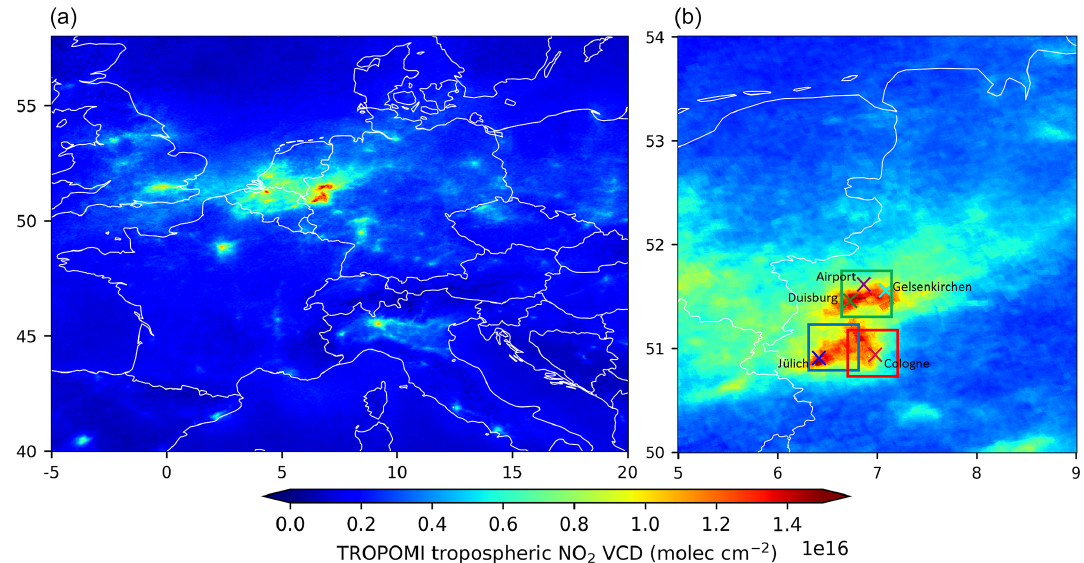
Figure 1. S5P TROPOMI tropospheric NO 2 VCD taken from the PAL V02.03.01 product for the month of September 2020 in central Europe (a) and a close-up map of the campaign target area in North Rhine-Westphalia (b) . The three research flight target areas and the ground-based measurement sites are shown.